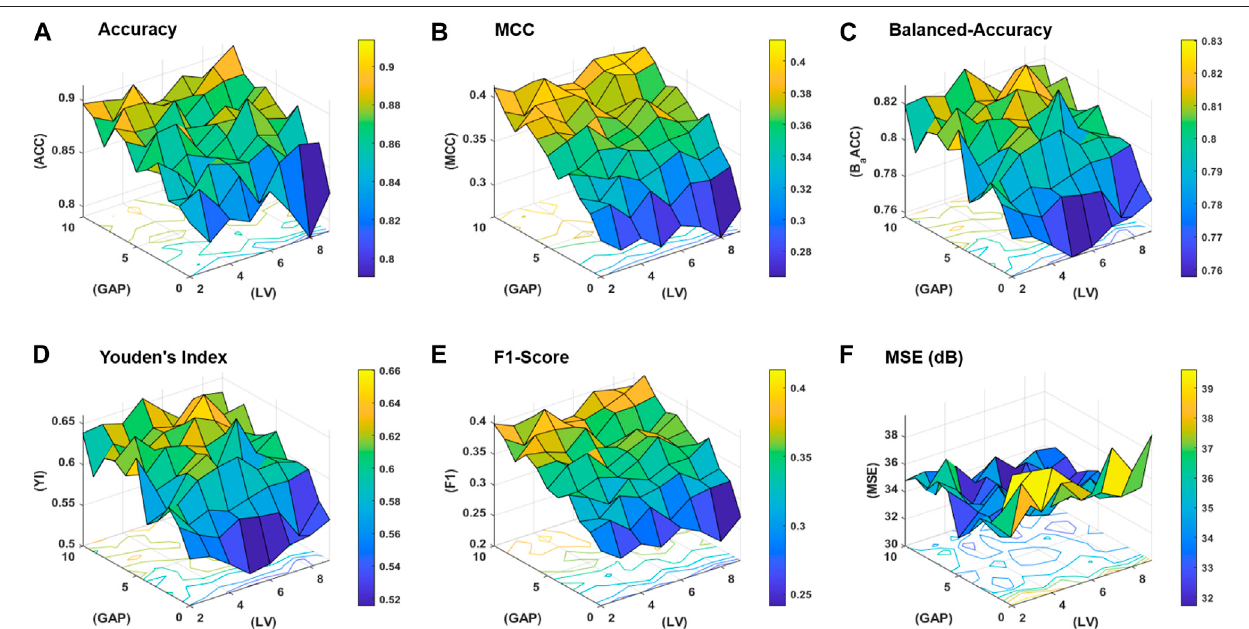
FIGURE 4 | Performance statistics surfaces for: (A) accuracy, (B) MCC, (C) balanced-accuracy, (D) Youden ’ s Index, (E) F1-Score, and (F) mean squared error (MSE) in dB.